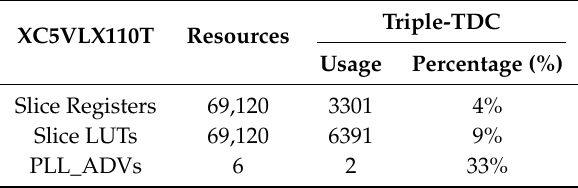
Table 1. Resource usage for FPGA